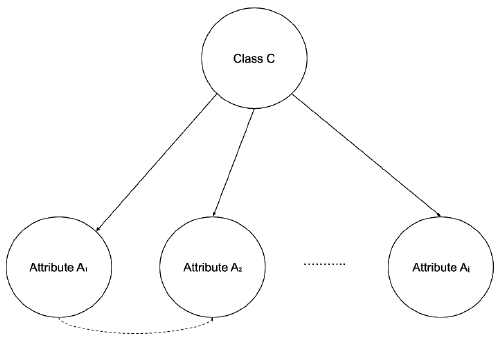
Figure 2. Tree augmented naive Bayesian (TAN)